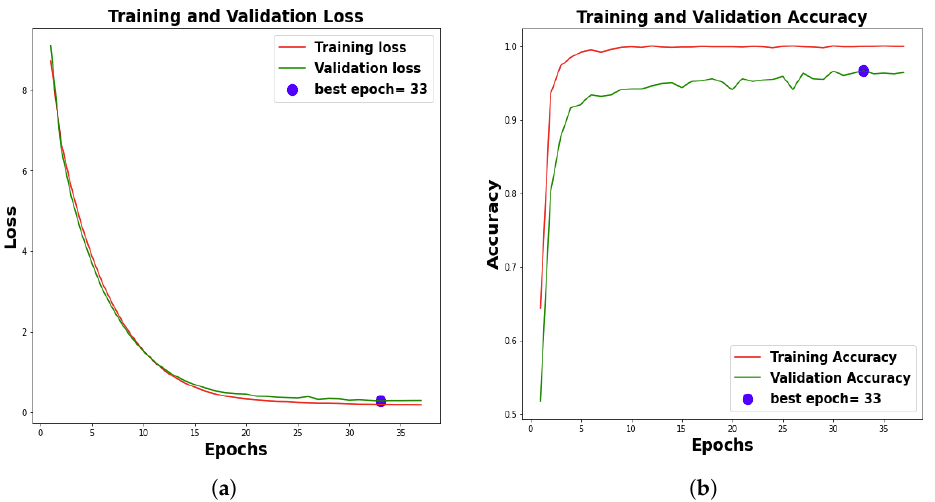
Figure 3. Training and validation results. ( a ) 99.84% ± 0.10% average training accuracy and 99.07% ± 0.38% average validation accuracy over 10 folds. ( b ) 0.18 ± 0.01 training loss and 0.24 ± 0.02 validation